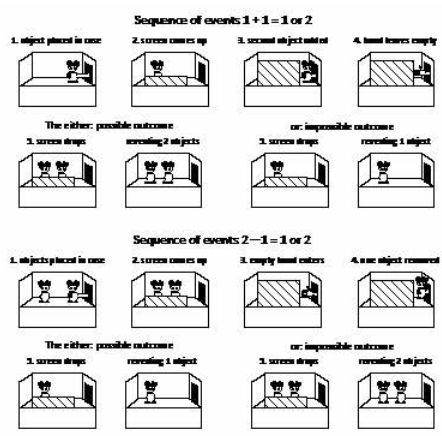
Figure 1: Sequence of events for 1 + 1 and 2 – 1 situations (Wynn, 1992a:749). Infants can discriminate or match precisely collections of one to three elements. Their ability is limited, however, to those small numerosities (Starkey & Cooper, 1980; see also subitizing). Although early sensitivity for numerosities in infants can be taken as a certainty, it is not easy to grasp the underlying concepts and